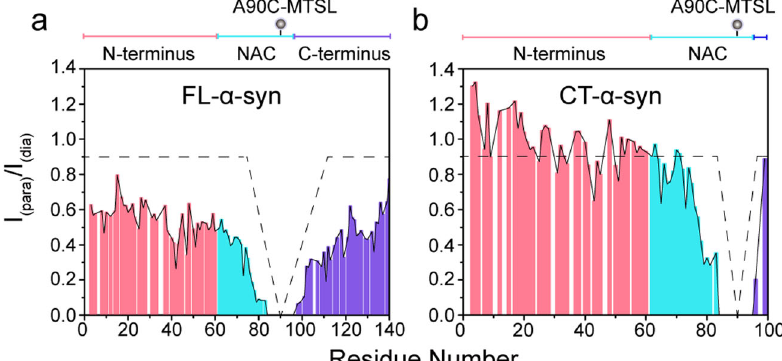
Fig. 3 A more extended conformation for CT- α -syn. a , b Intramolecular PRE intensity ratios of backbone amides in FL- ( a ) and CT- α -syn variants ( b ) possessing a MTSL spin label at A90C. Pink, blue, and burgundy identify the N-terminal, NAC and the C-terminal domain, respectively. Schematic diagram of sequence domain is shown above each plot. Circles indicate locations of the (Supplementary Fig. 2), thus the cytotoxicity of CT- α -syn may be (Fig. 4b and Supplementary Data 3). Thus, the C-terminal truncation mainly caused by enhanced monomer-membrane interactions. increases mitochondrial damage compared to the negative control To further con fi rm the functional consequences of CT- α -syn and FL- α -syn. We excluded the possibility that CT- α -syn aggregated on mitochondria, we isolated mitochondria from SK-N-SH cells. into oligomers or fi brils during 5 h incubation with SK-N-SH cells